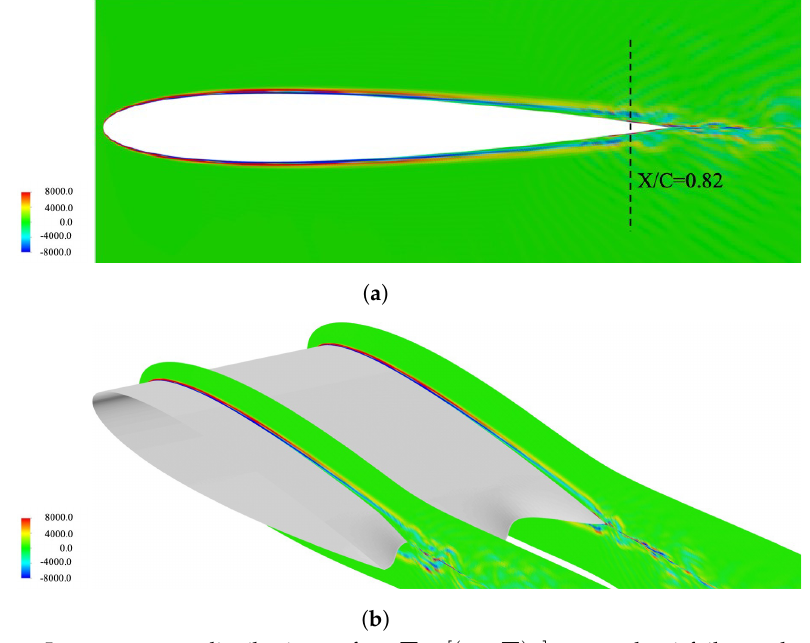
Figure 12. Instantaneous distribution of ρ 0 ∇ · [( u · ∇ ) u ] around airfoils, colored by